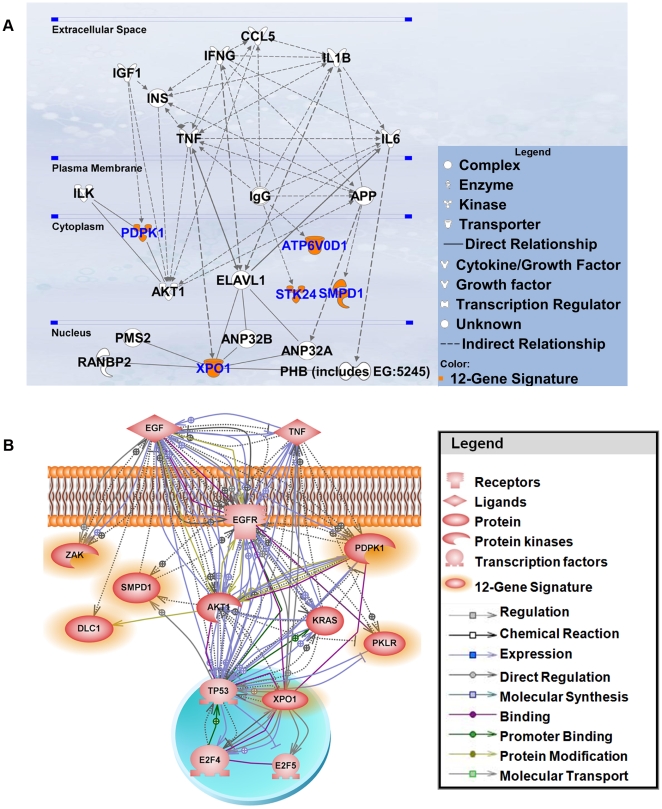
Functional pathway analysis of the 12 signature genes.(A) Using core analysis from Ingenuity Pathway Analysis (IPA), curated interactions were revealed among the identified signature genes and major lung cancer signaling pathways. (B) Six of the 12 signature genes also exhibited various curated interactions with eight prominent lung cancer hallmarks with Pathway Studio 7.0.